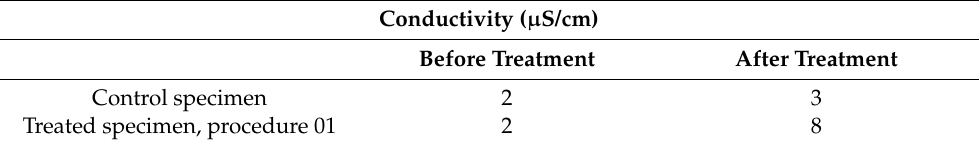
Table 2. Values of the conductivity before and after the treatment performed by using nanolimes. Conductivity ( µ S/cm) Before Treatment After Treatment Control specimen 2 3 Treated specimen, procedure